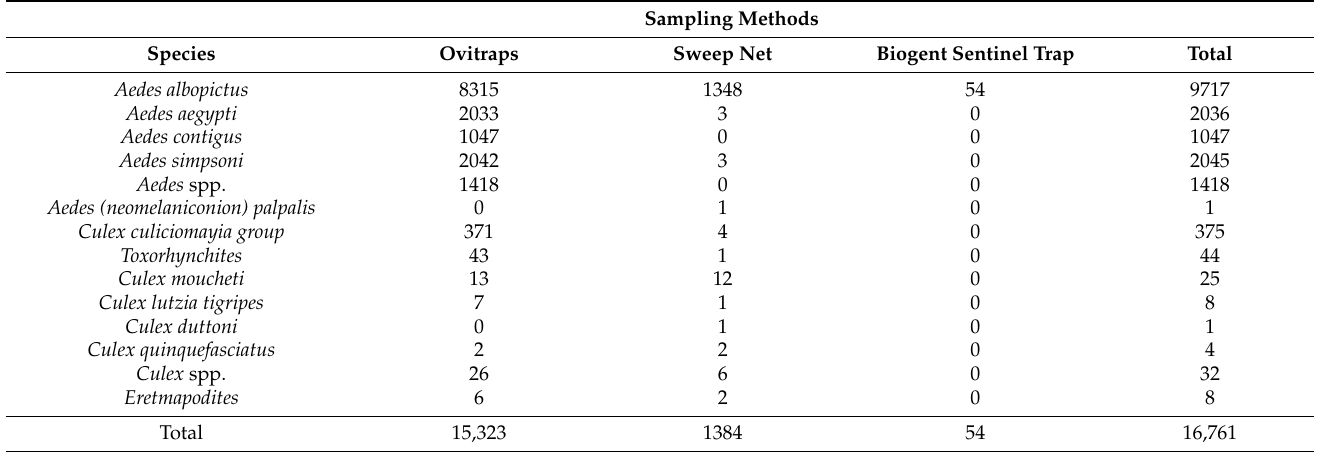
Table 2. Species distribution according to sampling methods.